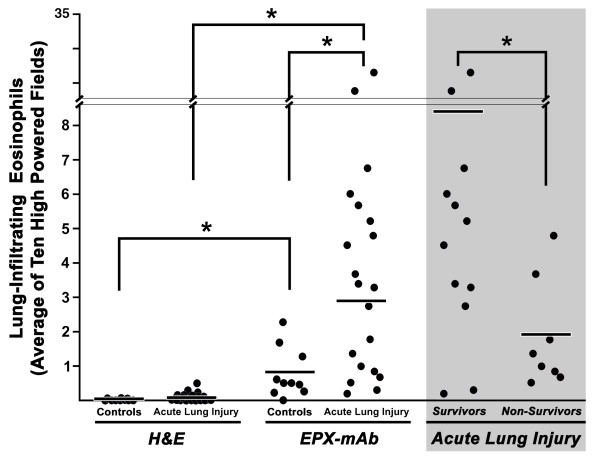
Assessment of individual patient biopsies revealed that unlike traditional H&E histopathology, EPX-mAb immunohistochemistry demonstrated that ALI patients have increased levels of eosinophils relative to control subjects and that within the ALI cohort this increase correlated with patient survival. Serial sections from either control subjects or acute lung injury patients were stained with H&E and subjected to EPX-mAb immunohistochemistry prior to evaluation for infiltrating eosinophil numbers per high powered field. Eosinophil counts per hpf were determined by individual investigators (n = 2) as the average count resulting from the examination of 10 randomly selected fields; investigators were blinded to both the clinical outcome and the scores of the fellow evaluator. The scatter plots presented represent values for each individual patient derived as the mean of the average eosinophil counts from these evaluators (ICC = 0.785 (95% confidence interval: 0.540 to 0.908). The scatter plots within the shaded area represent acute lung injury patients following EPX-mAb immunohistochemistry that were then stratified (following decoding of the data) on the basis of their hospital survival. The mean for each cohort is presented as a horizontal bar. *p < 0.01